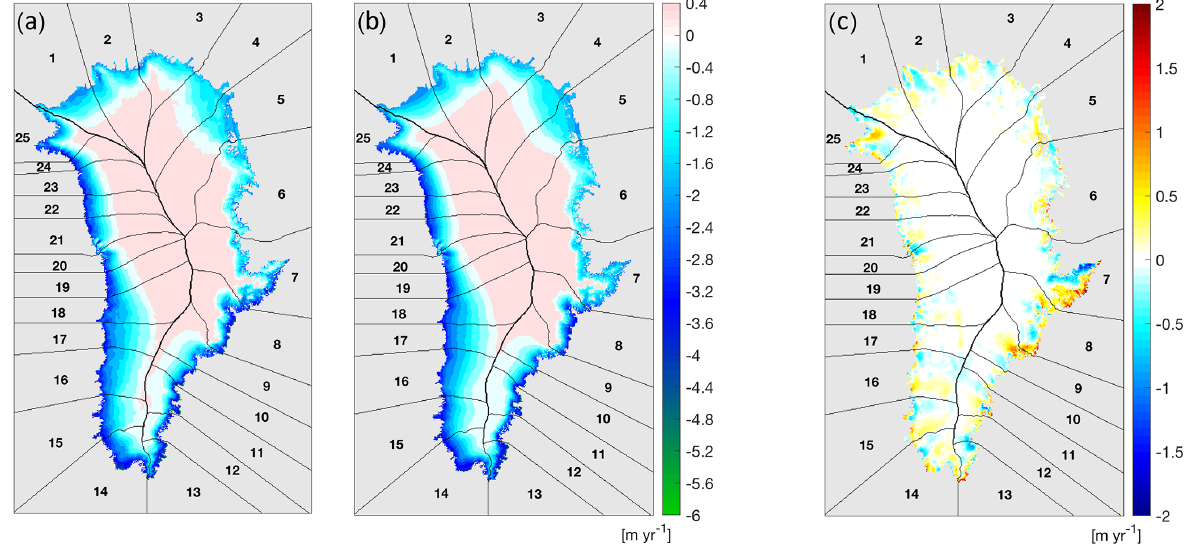
Figure 5. (a) SMB anomaly from the RCM MAR for the observed geometry, (b) remapped to the same observed geometry. The differences between (b) and (a) are shown in (c) .